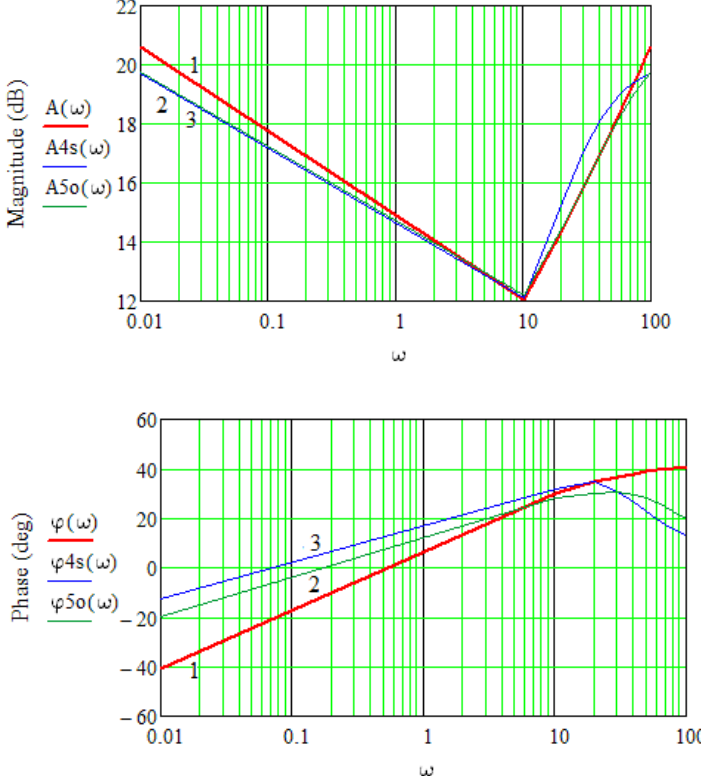
Figure 8. Reference frequency characteristics 1 and frequency characteristics for the TF, approxi- mated by the methods of Oustaloup 2 and chain fractions 3. by the methods of Oustaloup 2 and chain fractions